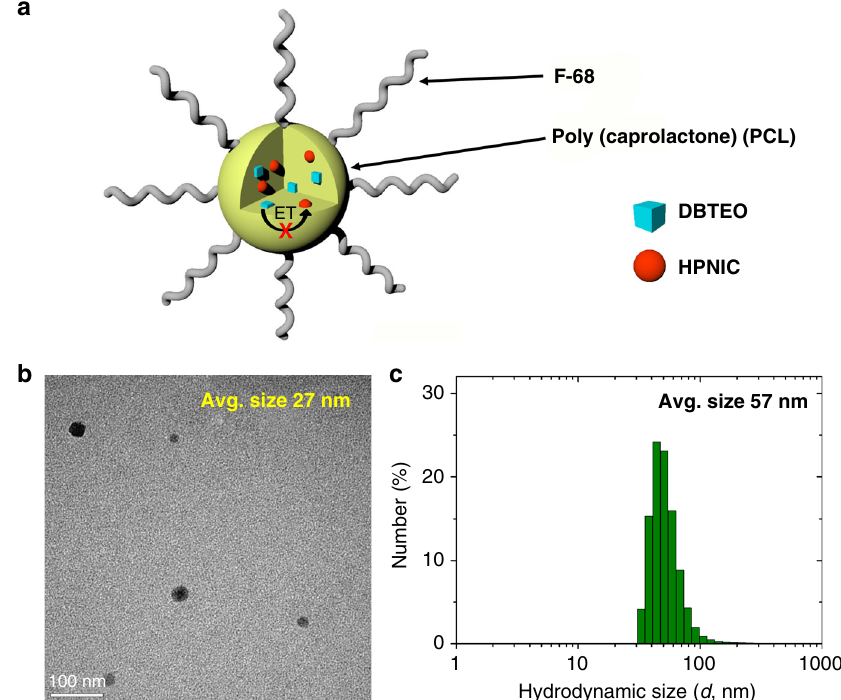
Fig. 5 Biocompatible nanoparticles. a Schematic representation of the PCL nanoparticles (NPs) doped with DBTEO and HPNIC and their photoswitching reaction by UV/visible-light irradiations. b Field-emission transmission electron microscopic (FE-TEM) image of the NPs. c Size distribution and average size of the NPs in water measured by dynamic light scattering (DLS)